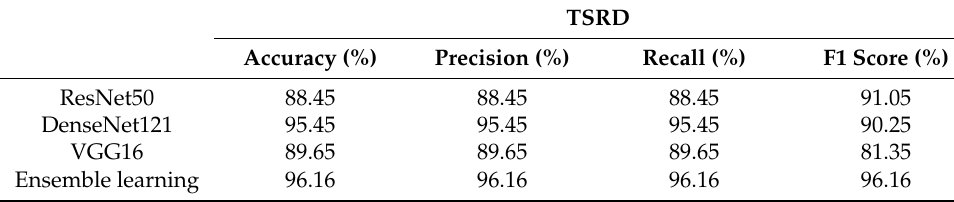
Table 11. Accuracy, precision, recall, and F1 score on